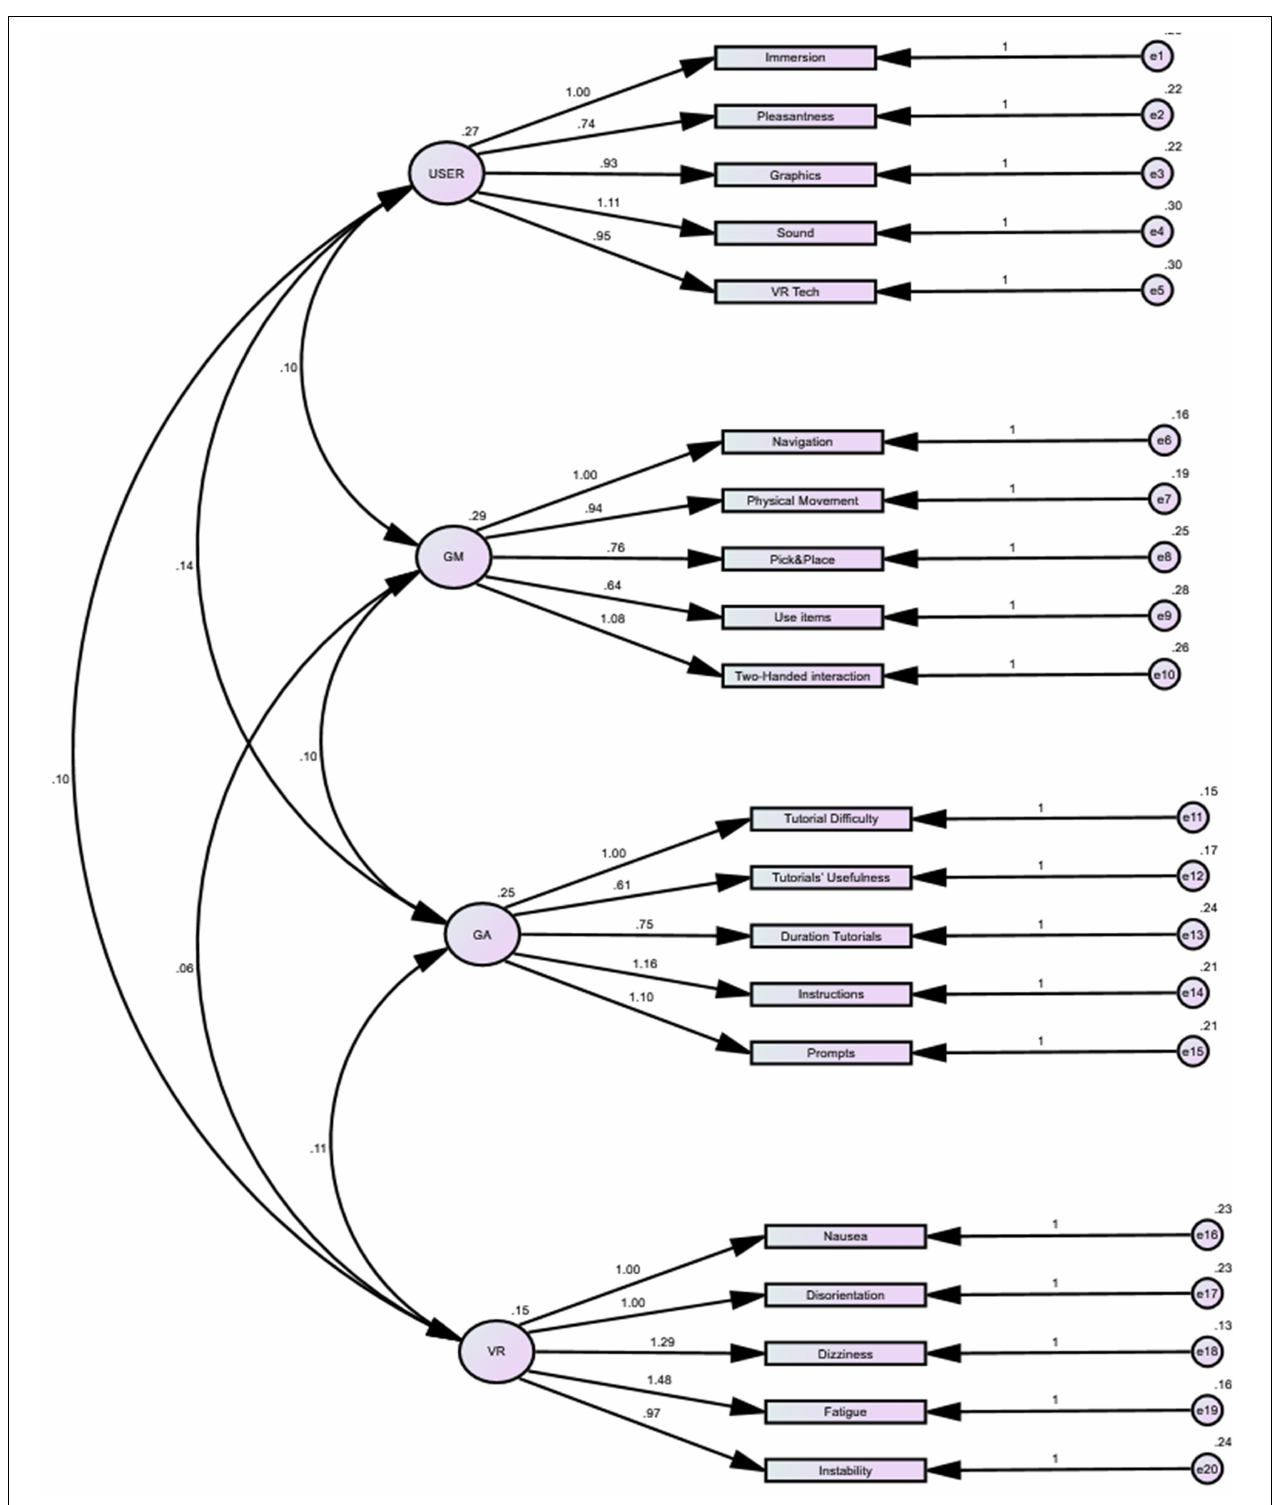
FIGURE 1 | CFA: model’s path diagram. From left to right: the structural model illustrates the associations between VRNQ domains (paths with double headed arrow) and between each VRNQ domain and its items. At the right there are the error items (e) for each item; USER, user experience; GM, game mechanics; GA, in-game assistance; VR,